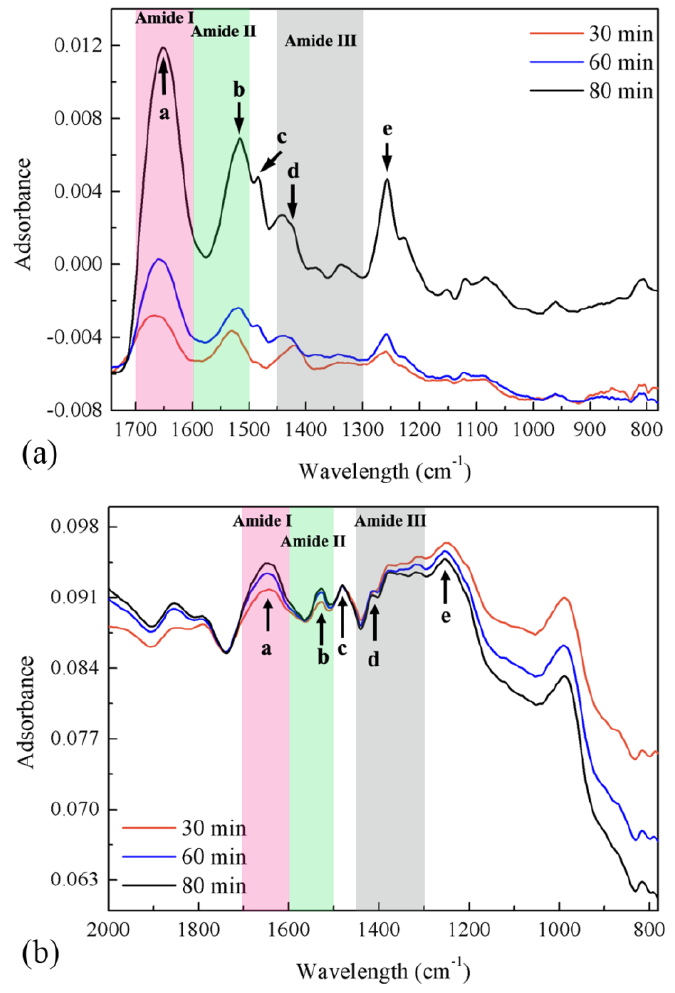
Figure 5. Infrared spectra of ( a ) Mefp -1 film and ( b ) Mefp -1/graphene film on carbon steel surface with different film growth time. with different film growth time. Table 1. Assignments of characteristic peaks in Figure 5. Table 1. Assignments of characteristic peaks in Figure